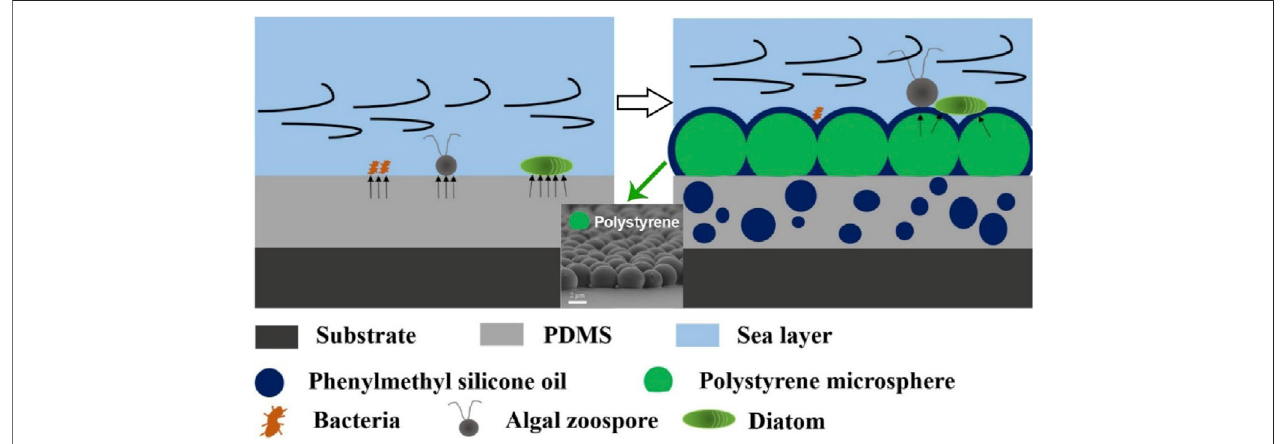
FIGURE2| SynergisticdefenseofPSO(phenylmethylsiliconeoil)/PDMS(polydimethylsiloxane)-PS(polystyrene)coatingagainstbiofoulings(Modi fi edfromRef.Mo et al., 2021).